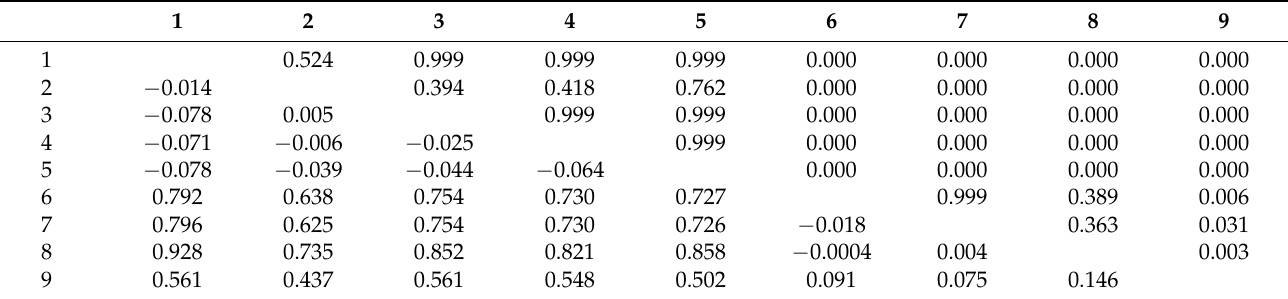
Table 3. Pairwise FST analysis among sampled localities (below diagonal). P -values above the diagonal. Significant values ( p < 0.001 Bonferroni corrections) after 1000 permutations. Code for localities: 1 = Callao, 2 = Coquimbo, 3 = Duao, 4 = Constituci ó n, 5 = Talcahuano, 6 = Puerto Montt, 7 = Guaitecas, 8 = Puerto Madryn, 9 = Mar del